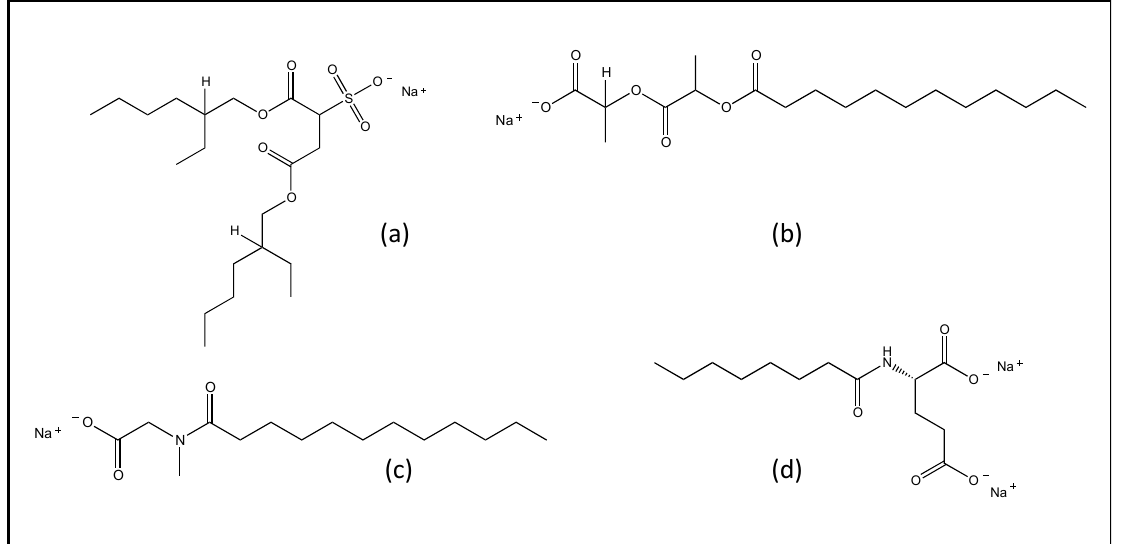
Figure 1. Chemical structure of anionic surfactants used in liposome composition: Sodium docusate (SD) ( a ); Protelan AG8 (PAG) ( b ); N-lauroylsarcosine sodium salt (NLS) ( c ); sodium lauroyl lactylate (SLL) ( d ).